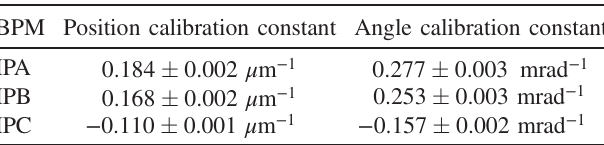
TABLE II. BPM position and angle calibration